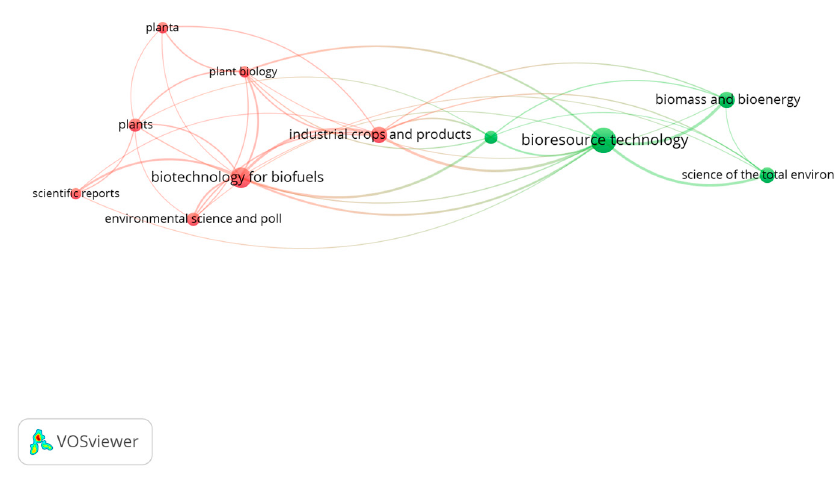
Figure 10. Co-citation map of the sources. With regard to analyzing organizations (337 in total), eight were in the network and had published a minimum of three documents cited at least three times. The Chinese Academy of Sciences (Beijing, China) was the most productive. This organization was also the most cited in the analyzed sample. However, the average year of the published documents affiliated with this organization is 2017.55, which means that currently, researchers from this university might not be highly active in the study field (Table 5.) Table 5. Organizations with high impacts based on normalized citations. Average Year Average Average Citations Total Link Strength Normalized Citations of Normalized Citations Publication